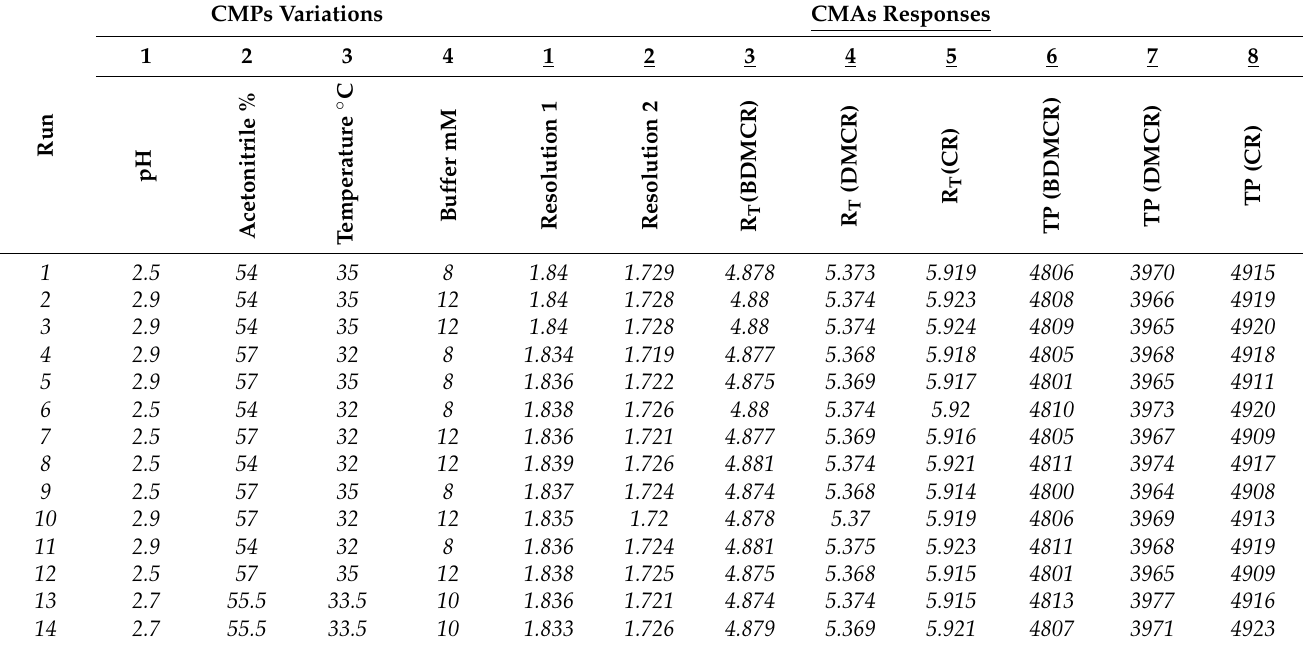
Table 5. The experimental plan and responses of the Plackett – Burman design for robustness test.